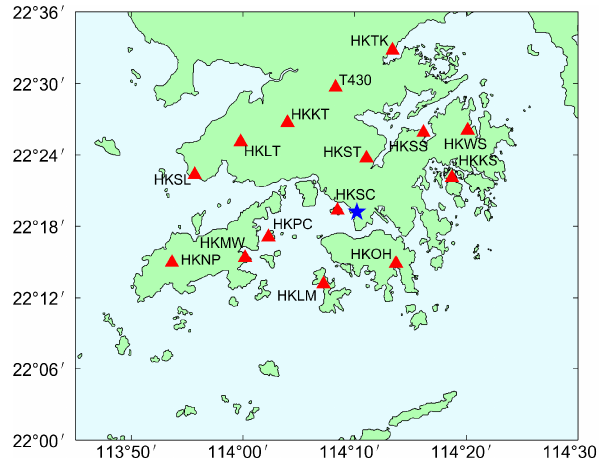
Figure 1. Research area of the experiment. The red triangles indi- cate the GNSS stations and the blue star indicates the radiosonde station in Hong